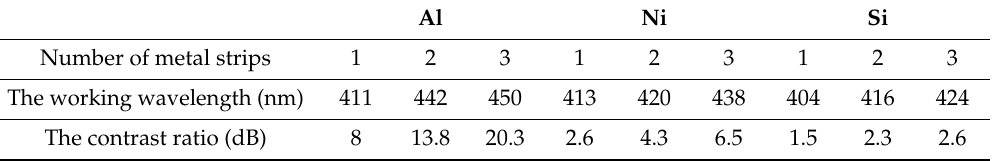
Figure 7. ( a – c ) The colors of the material in different cases; ( d ) CIE1931 color space inversion map distribution under different conditions. Table 1. The contrast ratio and the working wavelength of di ff erent material strips.